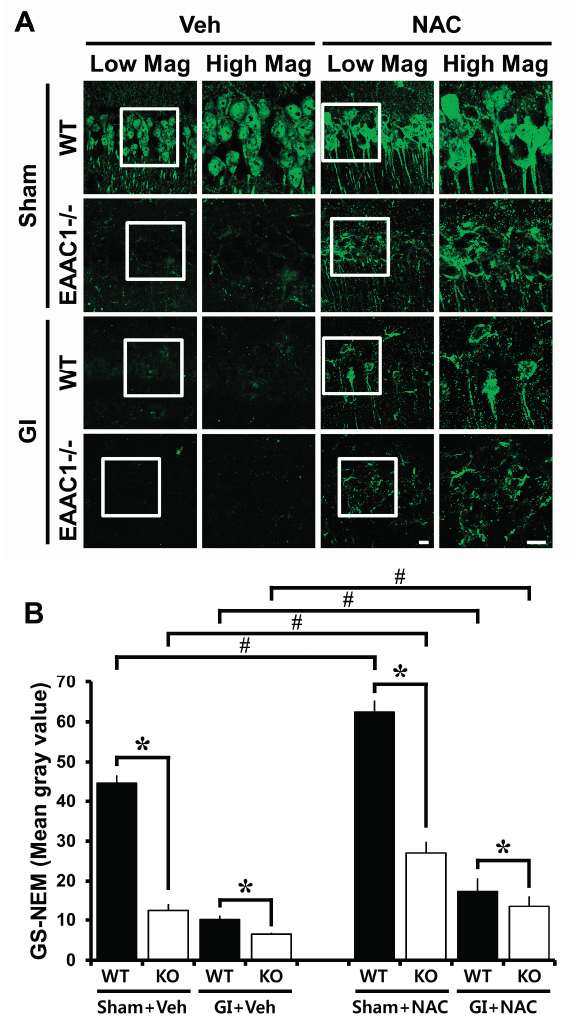
Figure 2. Neuronal glutathione deficiency in EAAC1 − / − mice is reversed by NAC treatment. Neuronal glutathione (GSH) was detected by GS-NEM immunofluorescence staining. ( A ) There was reduced fluorescence intensity in the neurons of EAAC1 − / − hippocampal sections compared to those in the wild-type slices. Ischemia-induced neuronal GSH reduction in the hippocampal CA1 is apparent in both wild-type (WT) and EAAC1 − / − mice. EAAC1 − / − mice show substantially increased neuronal GSH reduction compared to wild-type mice either after ischemia or after sham operation. This intensity was increased in hippocampal sections from mice treated with the cell-permeant cysteine precursor NAC in both wild-type and EAAC1 − / − mice after ischemia and sham operation. Scale bar = 10 μ m; ( B ) Quantification of neuronal GSH was performed from hippocampal CA1 pyramidal area. Bar graph represents mean gray value of GS-NEM fluorescent intensity. As shown in the images, neuronal GSH loss is aggravated in EAAC1 − / − mice. Data are mean + S.E.M.; n = 3, #, * p <